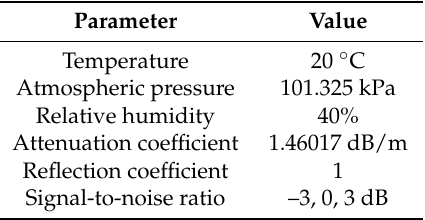
Table 1. Parameters for the